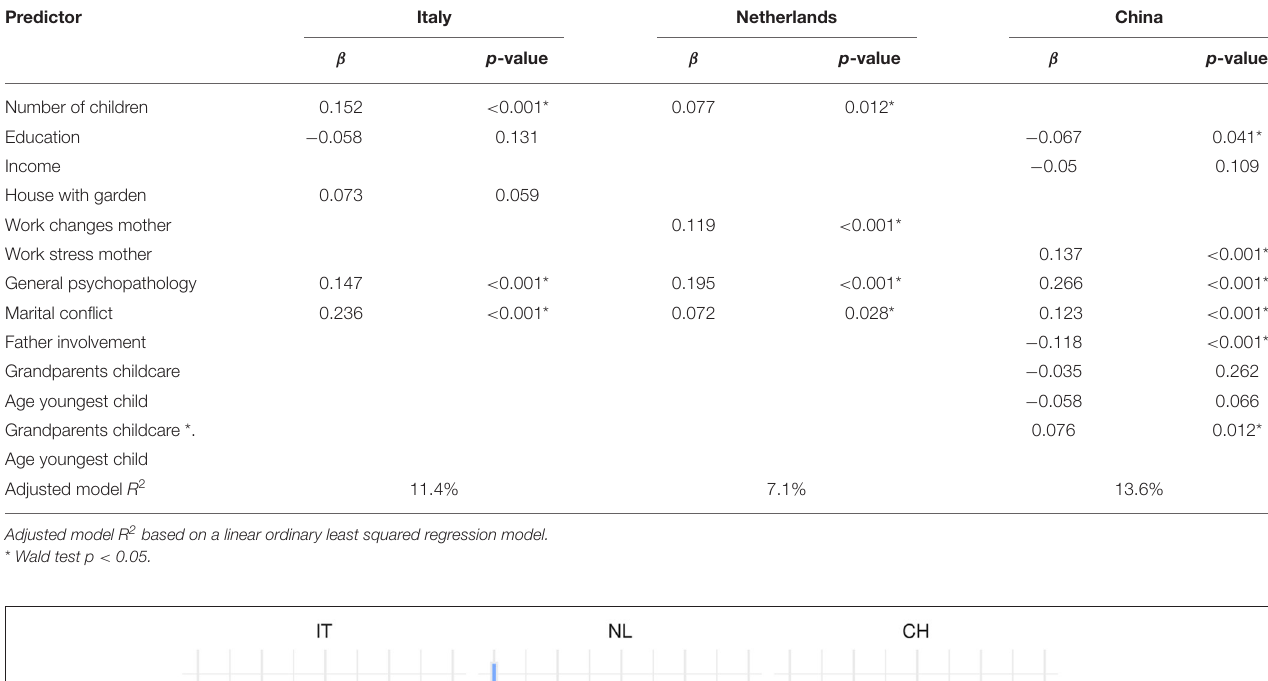
TABLE 2 | The standardized regression coefficients ( β ) and Wald test p -values according to robust regression analyses, including for each country only the predictors of the winning model. Predictor